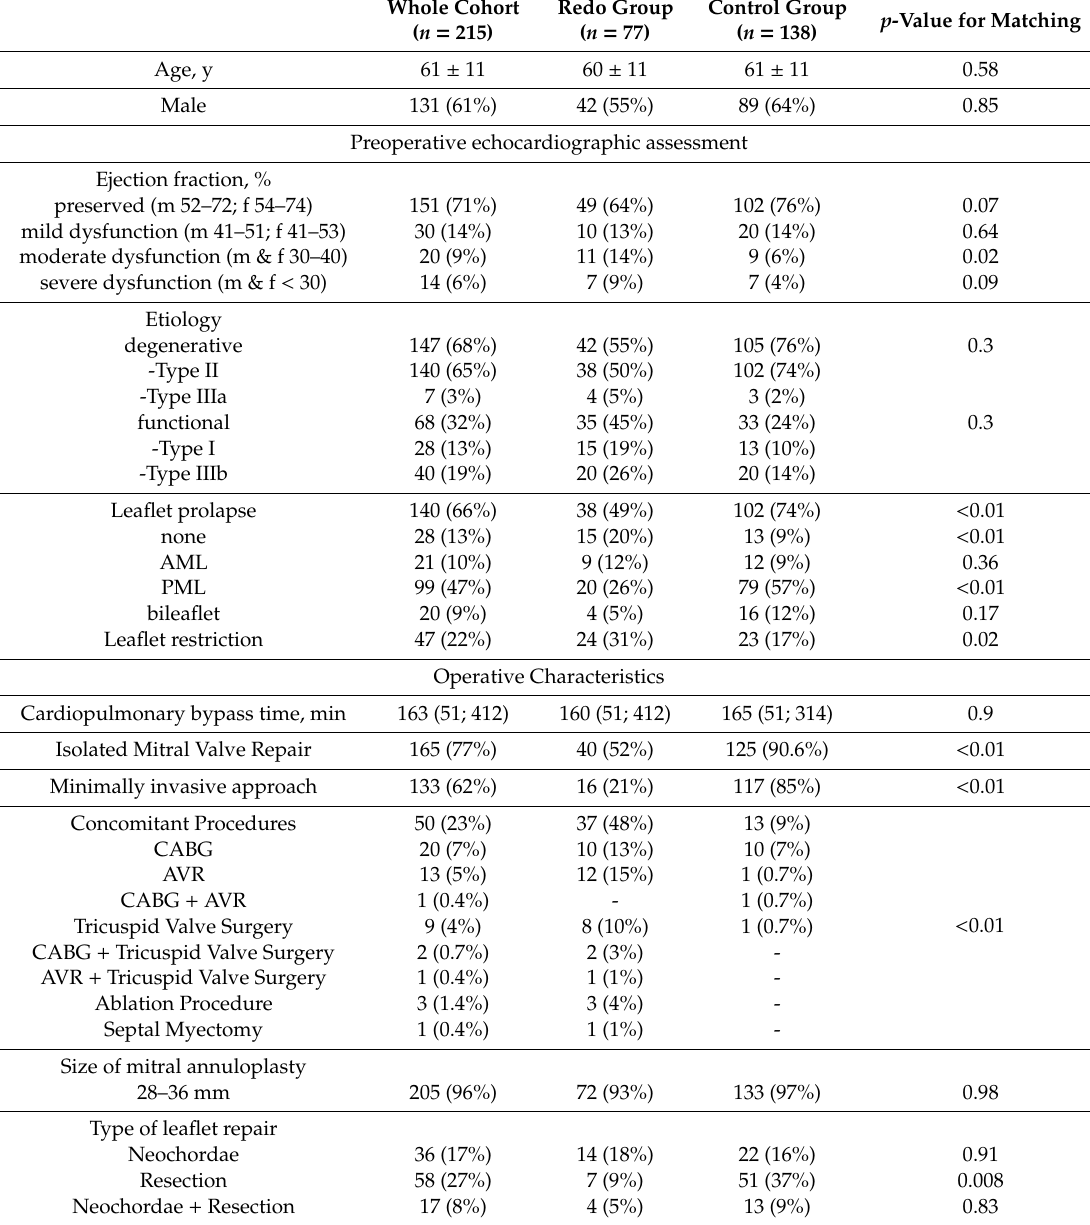
Table 1. Preoperative and operative characteristics and p -values for matching parameters. Echocardiographical data was collected before primary surgery and operative characteristics describe surgical strategy for primary